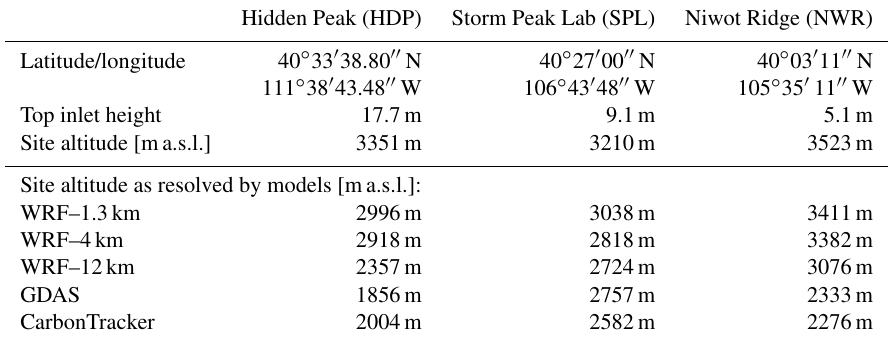
Table 1. Characteristics of RACCOON mountaintop sites examined in this paper, as well as the representation of terrain in different meteo- rological files at these